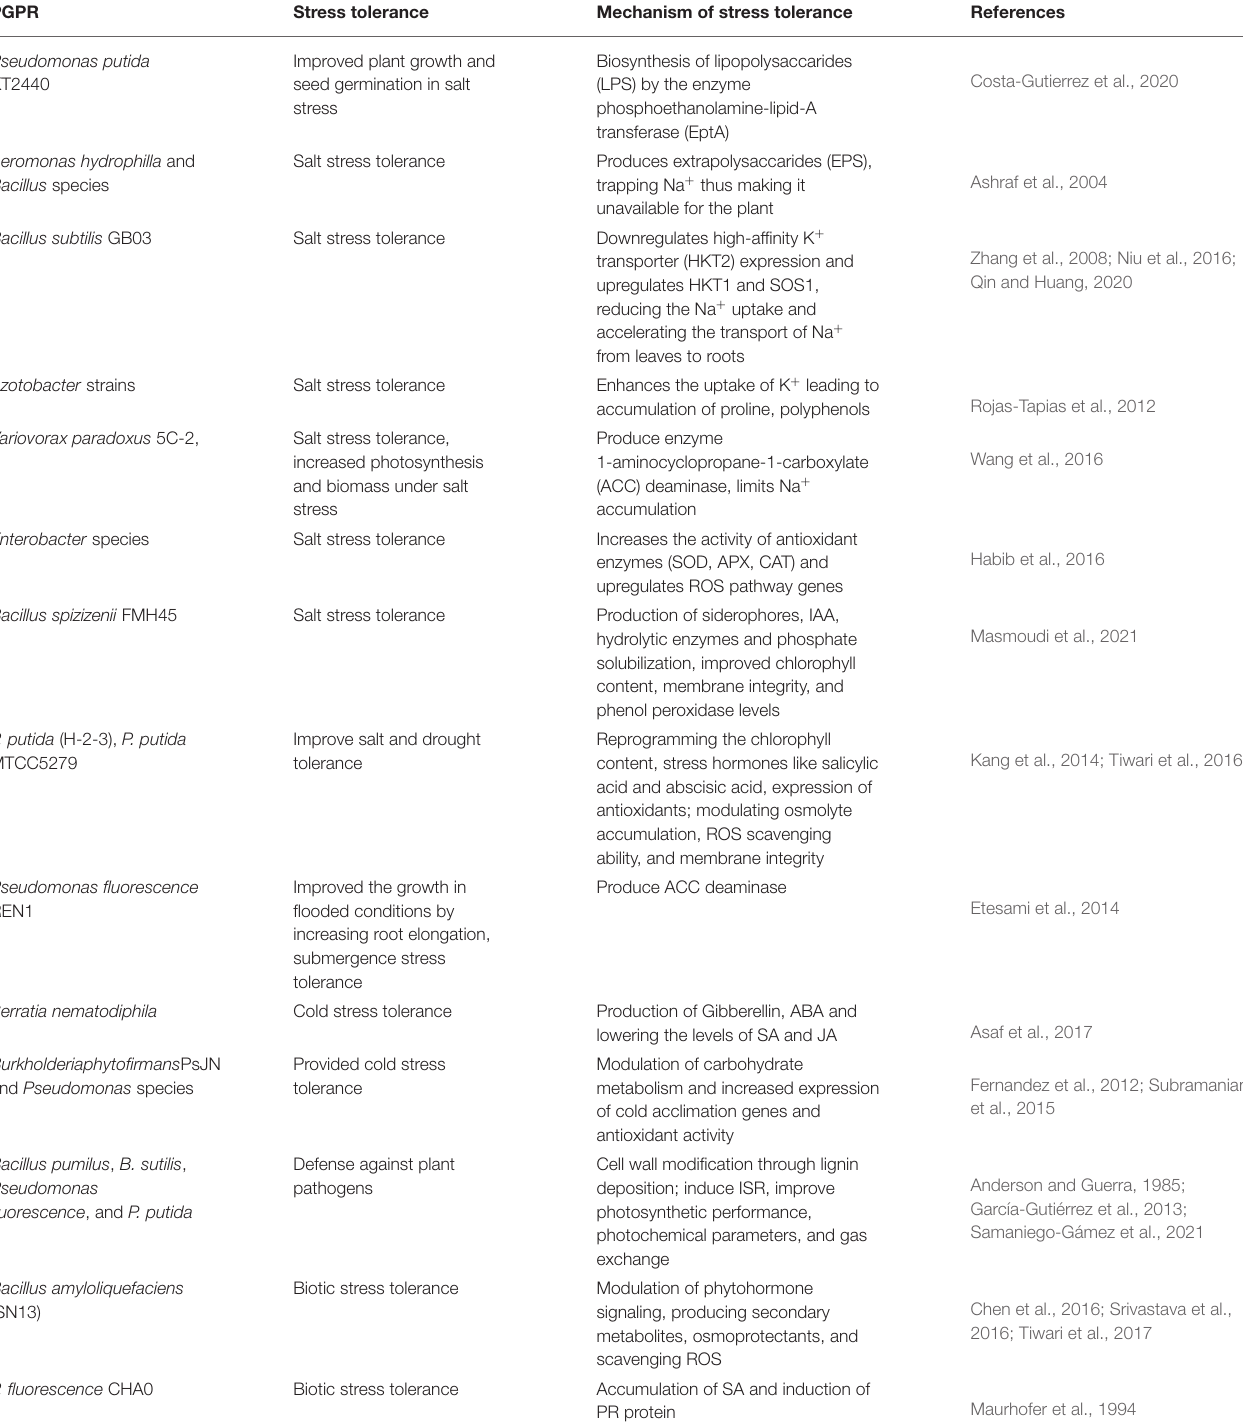
TABLE 2 | Mechanism of stress tolerance by